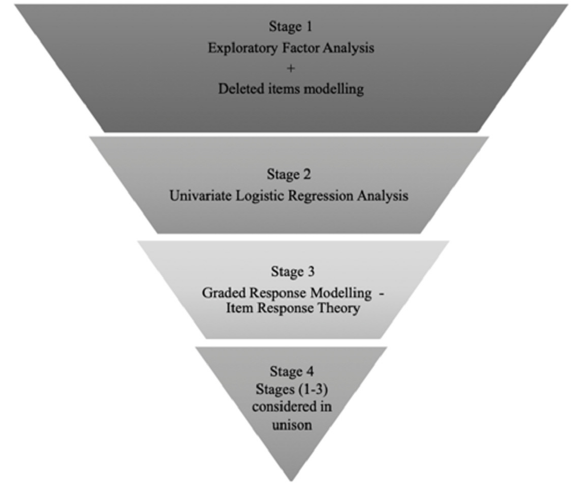
Figure 1. Scale reduction study design for a short form questionnaire.